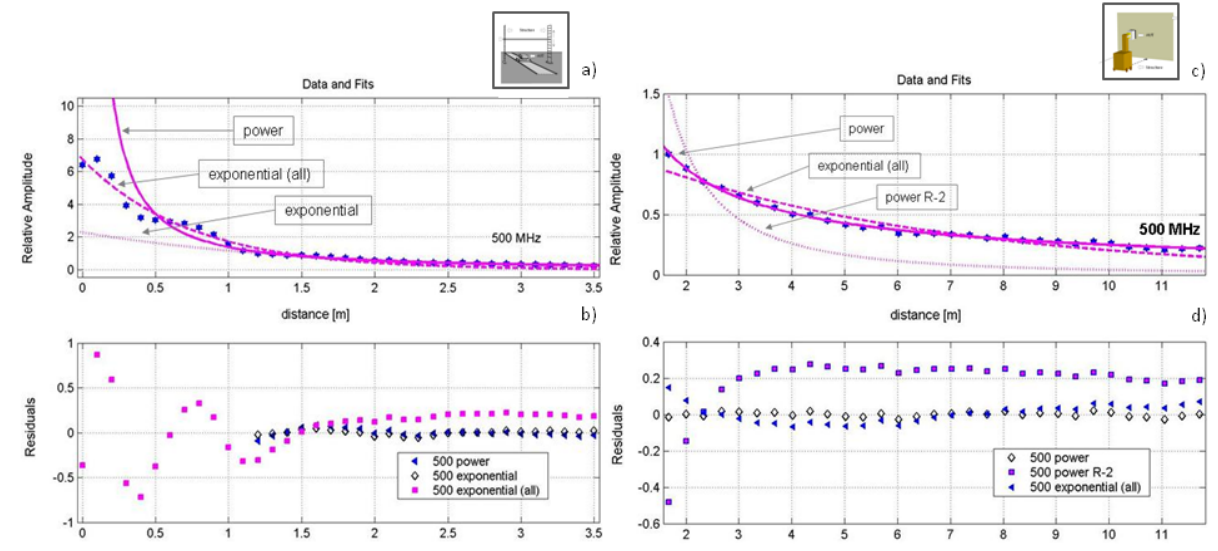
Figure 8. Maximum amplitude peaks of the reflected wavelet at different distances. For each methodology, three possible regression curves and their residual variations are shown. (a-b) Metallic bar. (c-d)